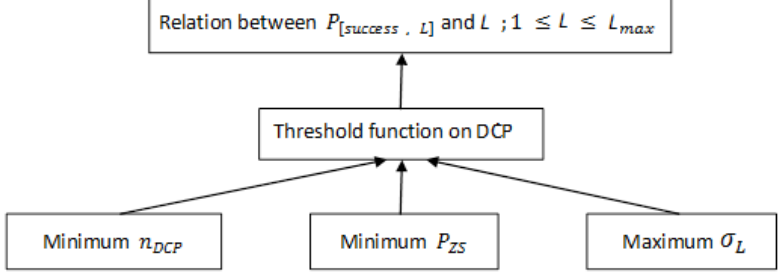
Figure 4. Parameters for selecting the best threshold